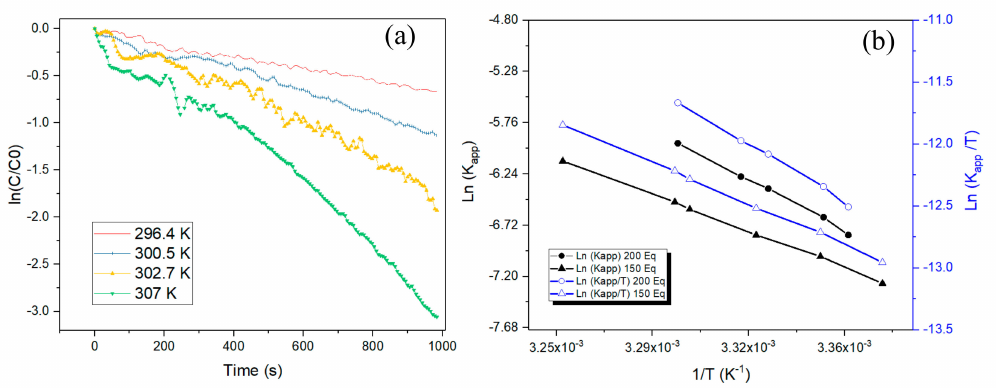
Figure 4. ( a ) ln ( C / C 0 ) versus time at di ff erent reaction temperatures, conditions of reaction 150 eq BH 4 − ; ( b ) Arrhenius plots ln( k app ) and Eyring plots ln( k app / T ) versus 1 / T for the Pd